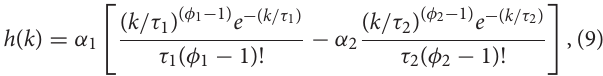
A designed hemodynamic response function (dHRF) is